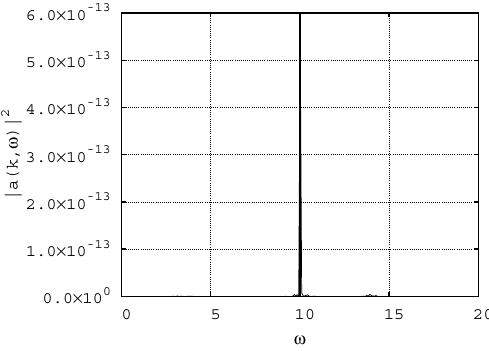
Figure 4. Spectral line of the harmonic k = (0, 100). Both the con- densate and inverse cascade were